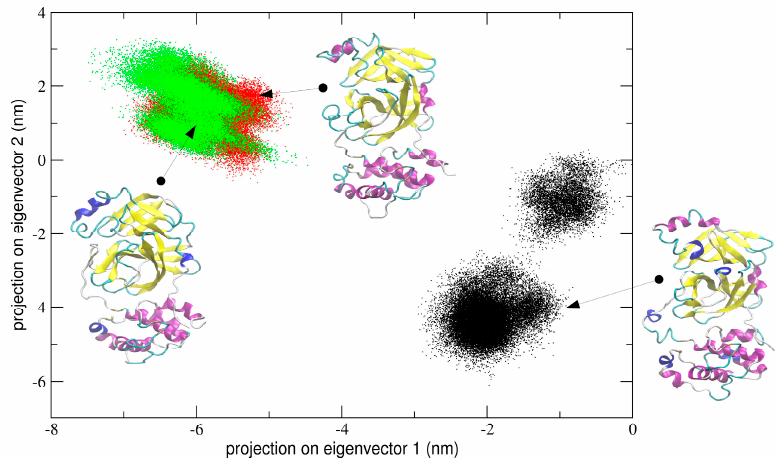
Figure 4. 2D projection of the concatenated dimeric protomers trajectory of run #1 on the essential subspace along eigenvectors 1 and 2. The structural basin visited by the chain A (black dots), chain B (red dots) in the dimeric form and the monomeric form (green dots) of 3CLpro is highlighted in different colors. The representative structures of the 2D projection on essential space are reported in the figure with the secondary structure elements colored in violet ( α -Helices), yellow ( β -strands), and cyan (loops).